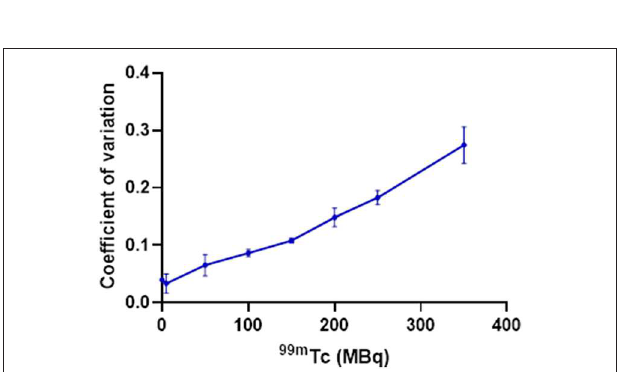
FIGURE 4 | Effect of increasing amounts of 99m Tc on the PET image quality of 5 MBq 18 F, quantified by calculating the coefficient of variation within an ROI for each image (SD/mean); n = 3.